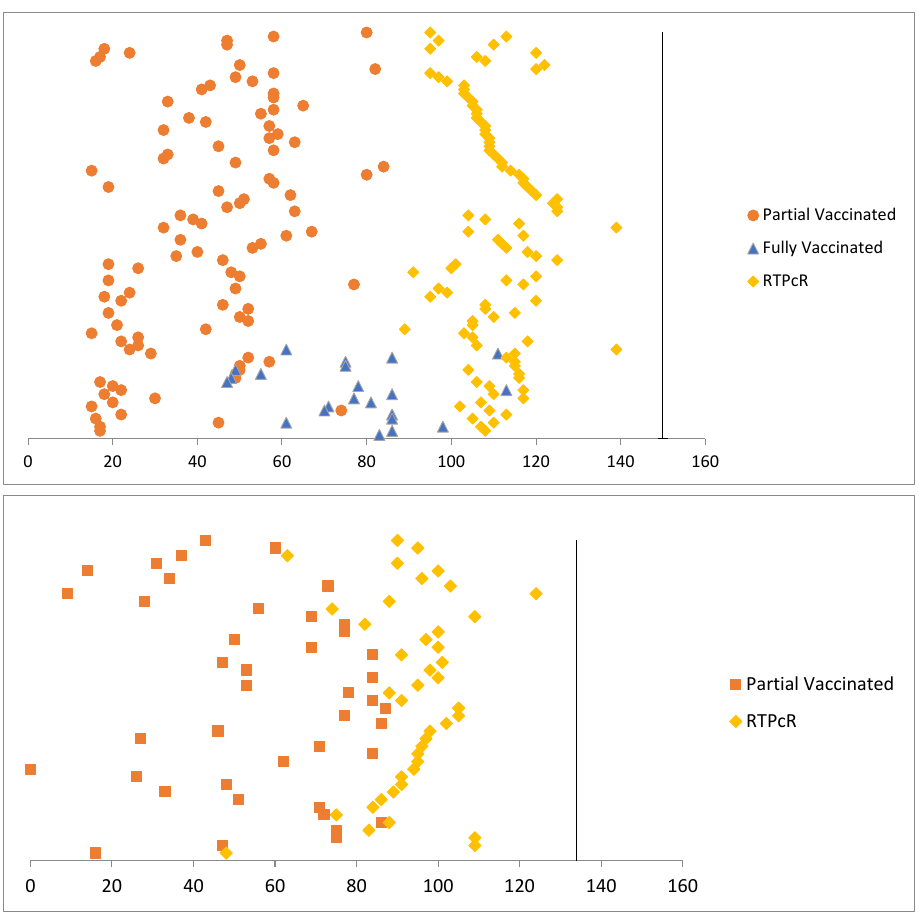
Figure 1. ( top and bottom ) depicts clinical chronology of the study’s samples in relation to rtPCR